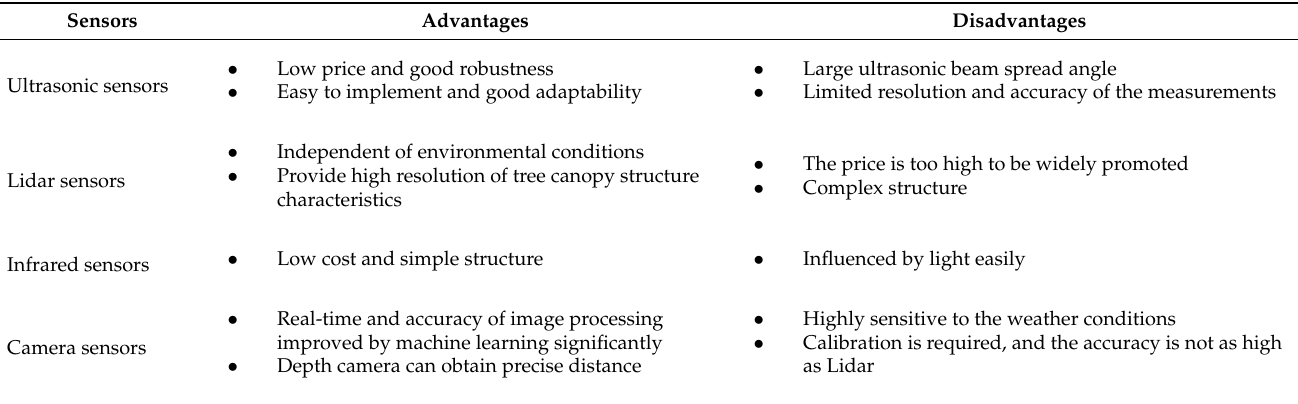
Table 1. Advantages and disadvantages of the different types of sensors used for geometrical characterization of tree